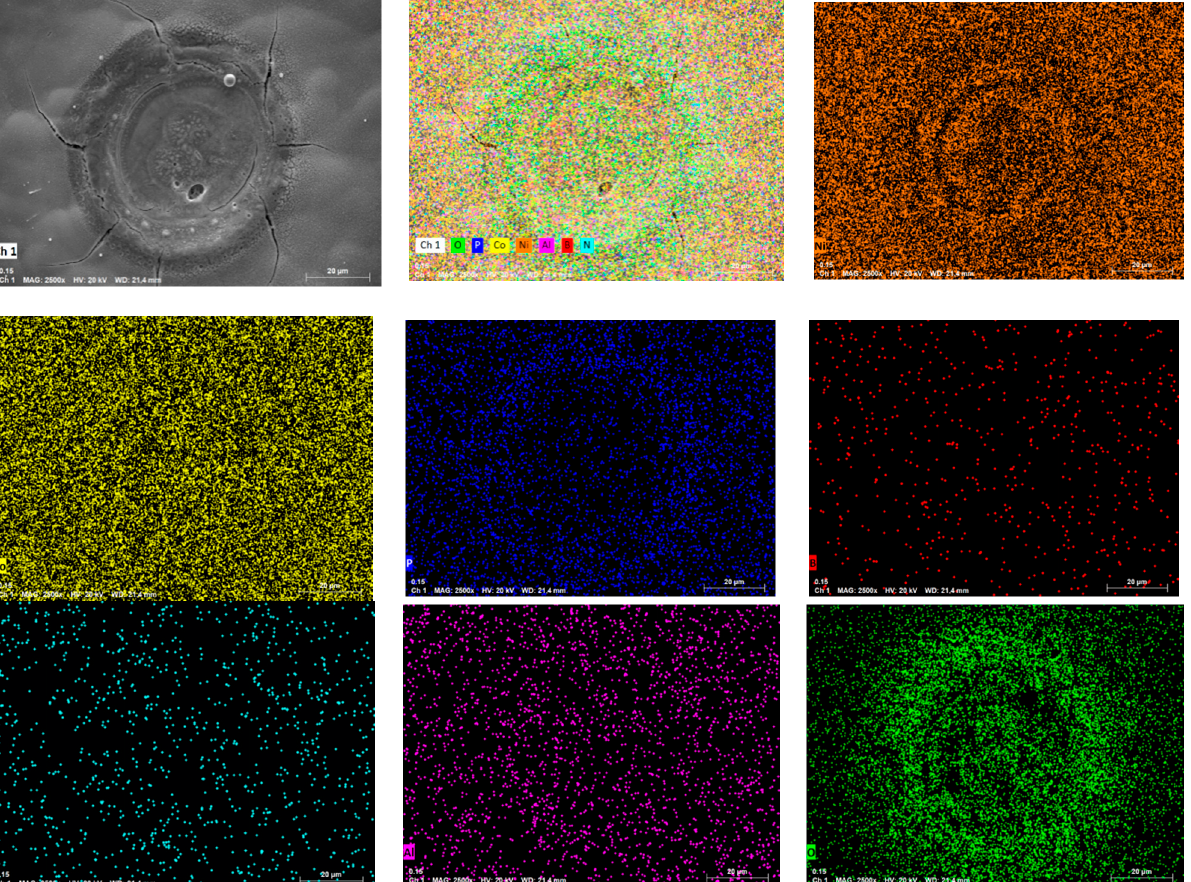
Figure 14. SEM images of textured surface with varying spot-to-spot distance: ( a ) 150 µm; ( b ) 200 µm; ( c ) 250 µm; ( d ) 300 µm.